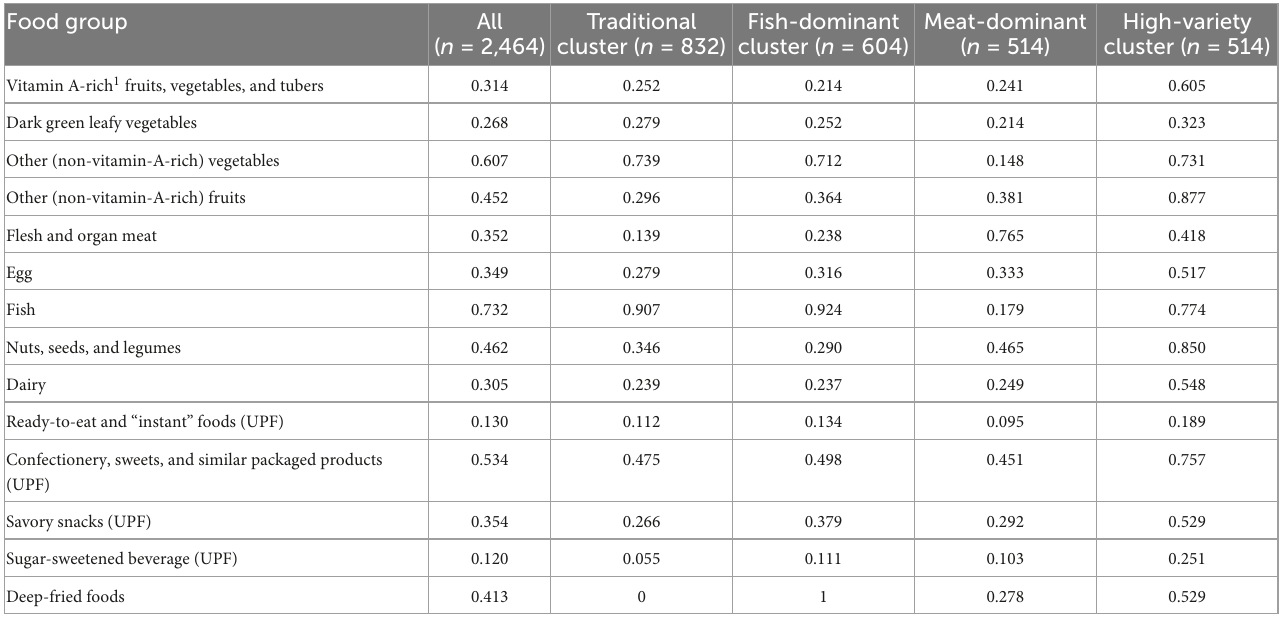
TABLE 1 Proportion of adolescents who consumed at least one tablespoonful ( ∼ 15 grams) of ≥ 1 item(s) from the 14 food groups by diet clusters. Food group All